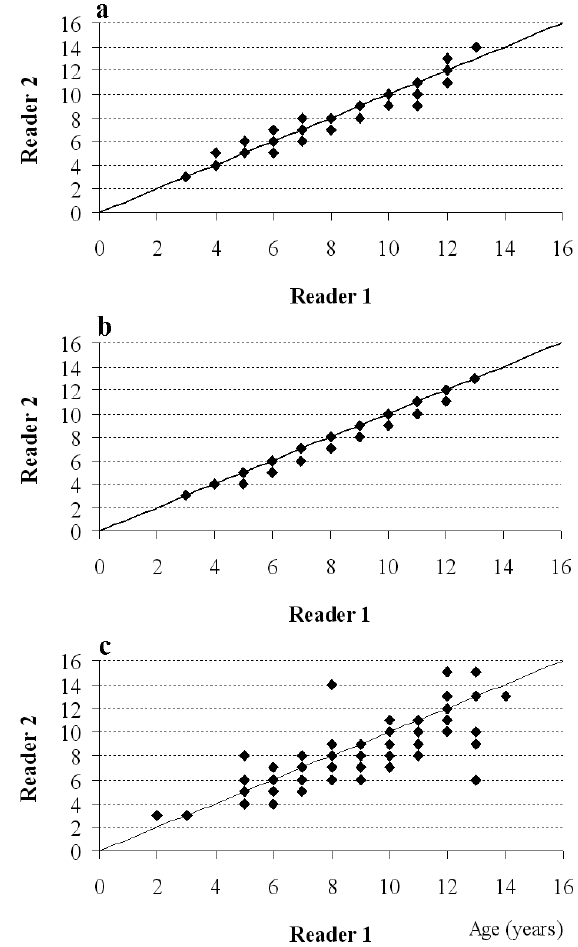
Fig . 8. – Agreement plot for comparisons between ages assigned by reader 1 and reader 2 for Aphanopus carbo specimens from mainland Portugal. (a) Whole otoliths. (b) sectioned otoliths. (c) Vertebrae. the 45º line represents 100% agreement.